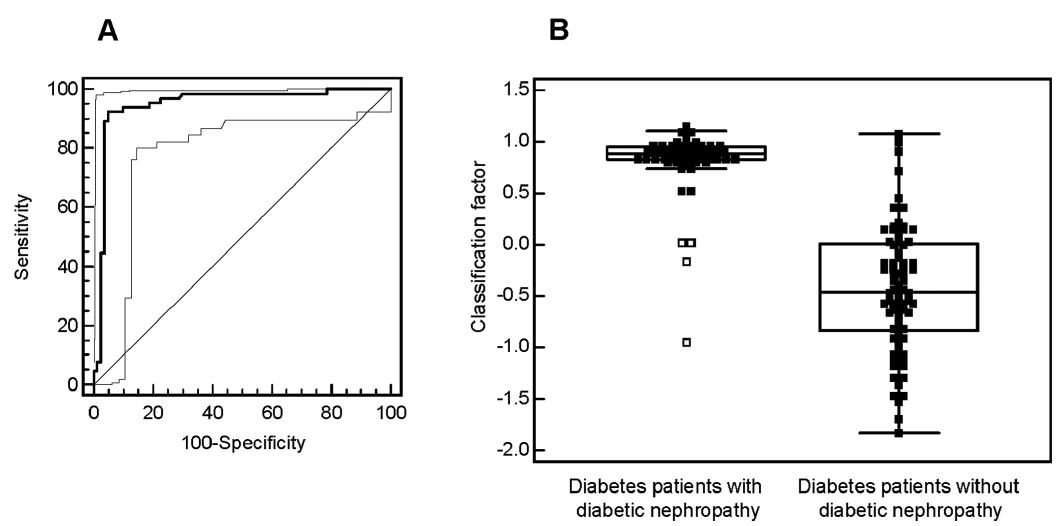
Figure 2. Statistical analysis of the classification results. A ) ROC curve and B ) Box-Whisker-plot for classification of the ‘case and control’ patient collective with the ‘DN’ pattern are shown.